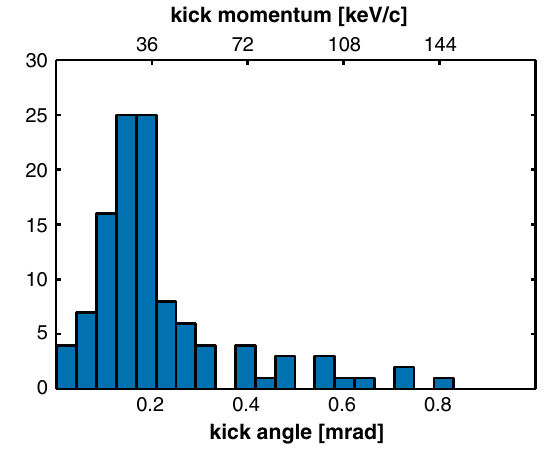
FIG. 8. Distribution of the total magnitude of rf breakdown kicks to the beam